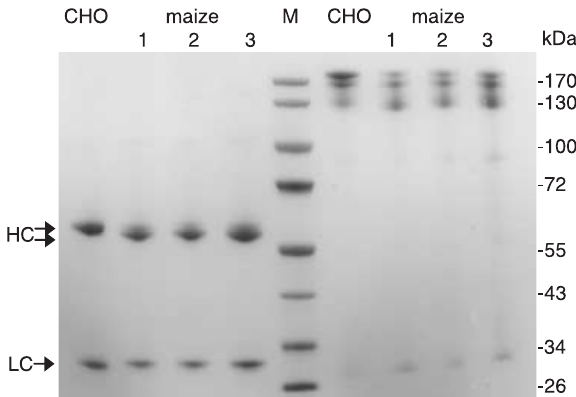
Figure 6 Sodium dodecylsulphate-polyacrylamide gel electrophoresis (SDS-PAGE) of purified 2G12 from Chinese hamster ovary (CHO) cells and maize seeds. Reduced (lanes 1–4) and non-reduced (lanes 6–9) samples (0.5 μ g) were separated on 4%–12% precast gels and stained with Coomassie. Lanes 1 and 6, CHO 2G12; lanes 2–4 and 7–9, three independent preparations of Zm 2G12 SEKDEL